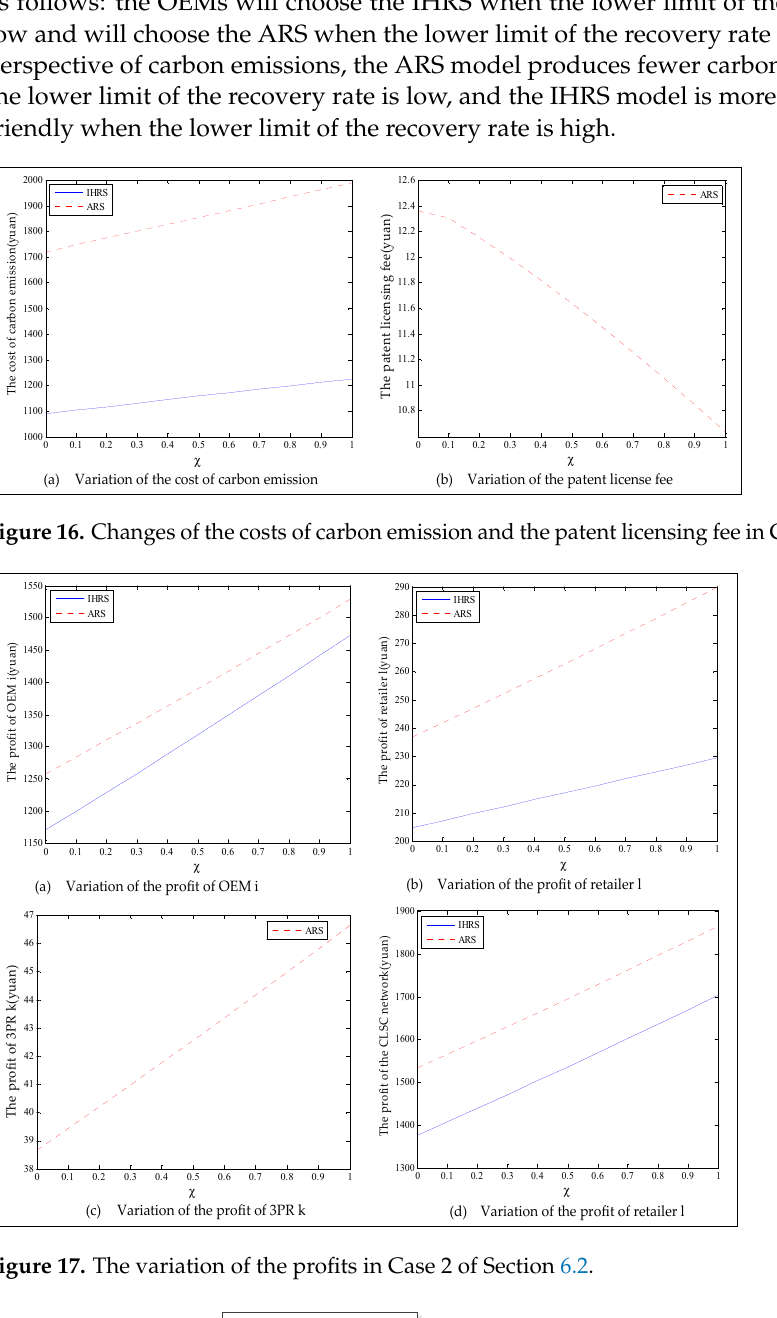
Figure 17. The variation of the profits in Case 2 of Section 6.2.